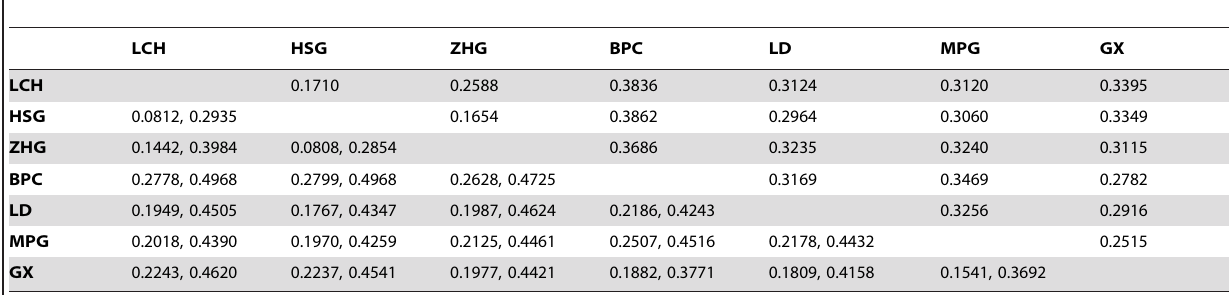
Table 5. Pairwise h B values (above diagonal) and their 95% confidence intervals (below diagonal) between Alsophila spinulosa